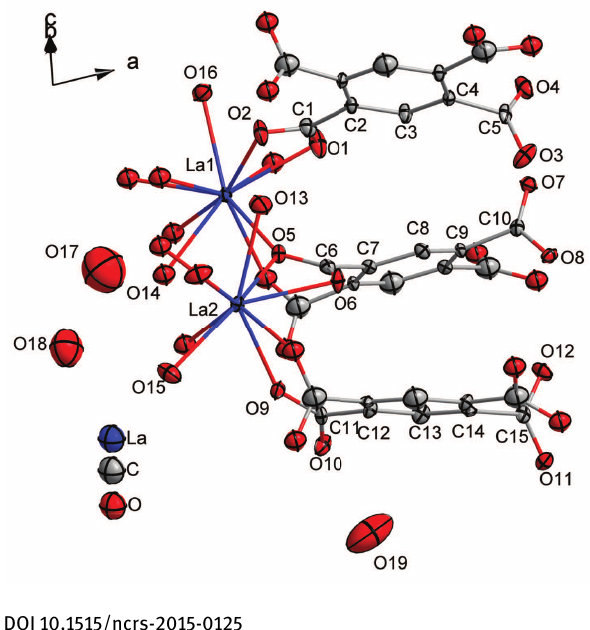
Table 1: Data collection and handling.